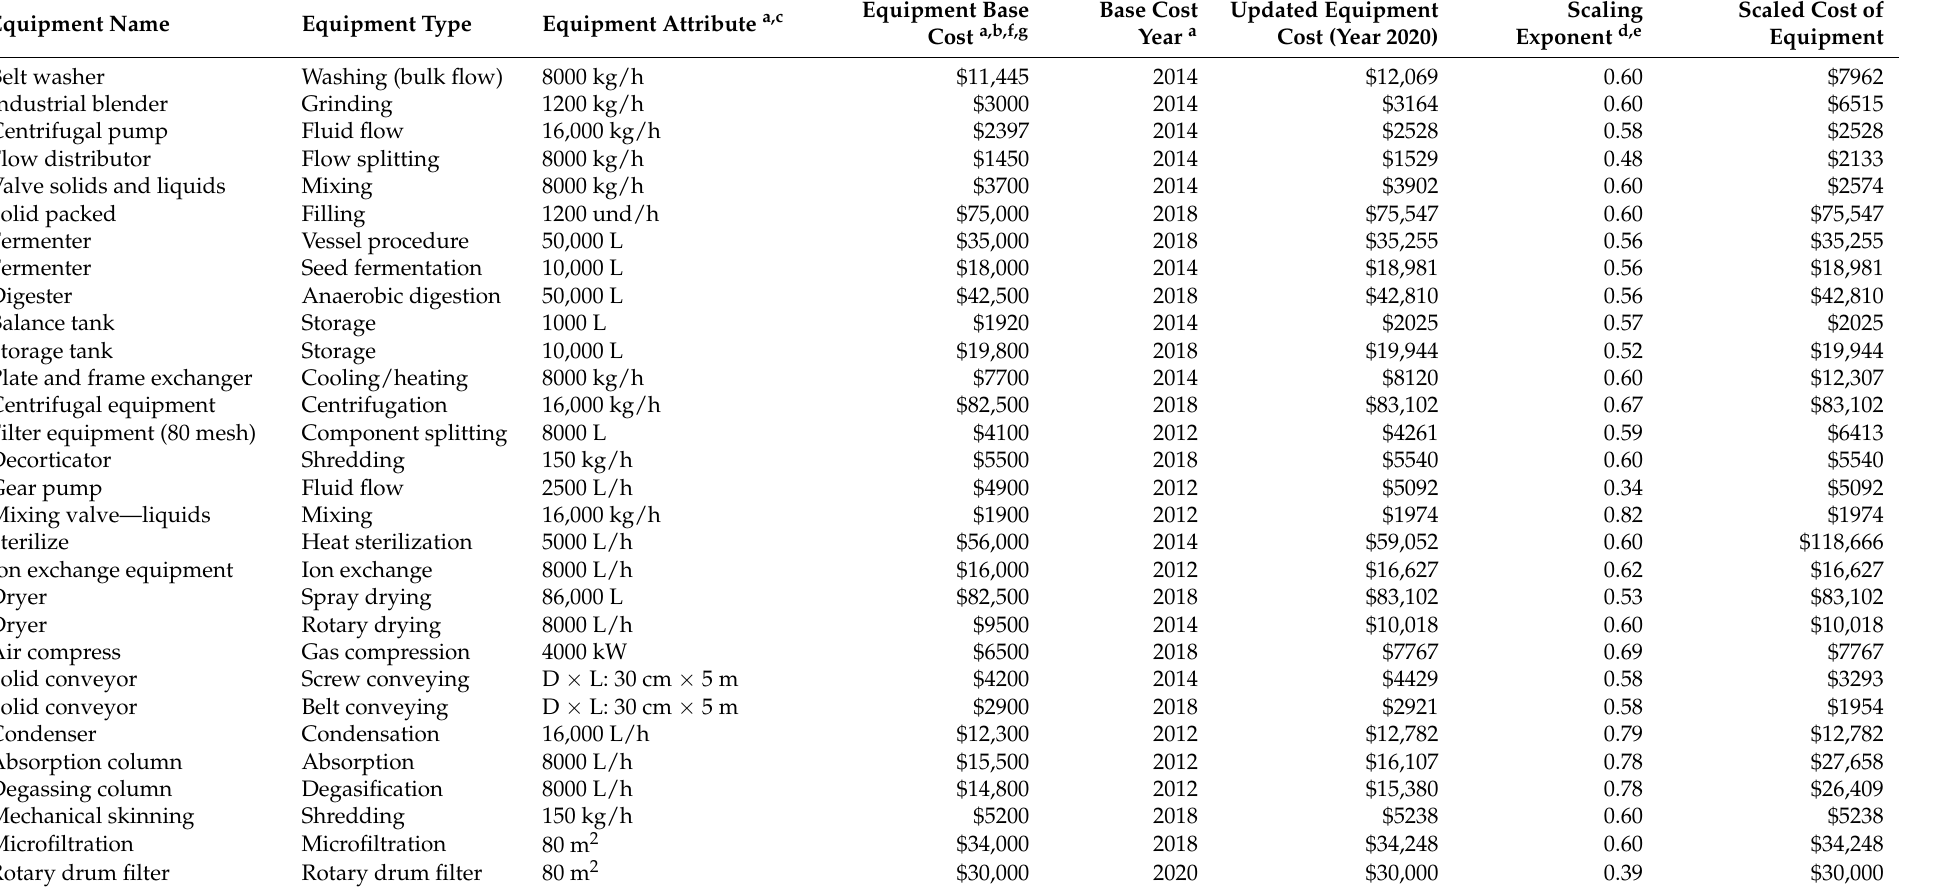
Table 3. Cost and specifications of the equipment used in the techno-economic assessment of the simulated process